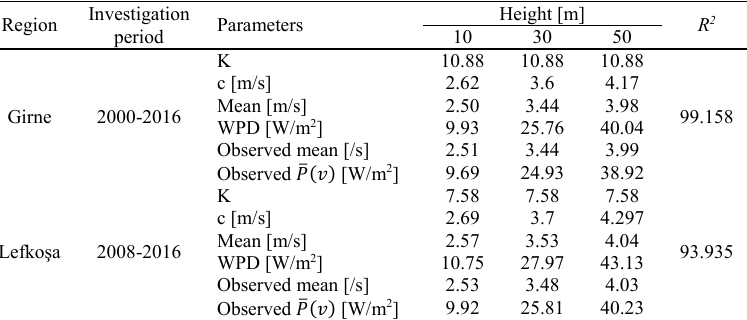
1.121.141.161.181.201.221.241.26 Fig. 8: Annual mean density at studied regions over the investigation period at 10m height (assumed constant) Table 4: Distribution parameters and WPD at different regions